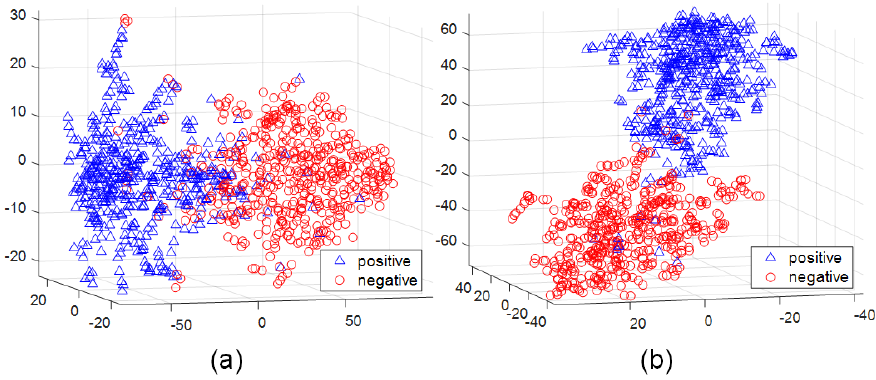
Figure 1. A visualization of the proposed MSSF after mapping it to a lower dimensional space: ( a ) computed features when the neighborhood contains outliers; ( b ) computed features when the neighborhood contains no outliers. Compared with ( a ), red points and blue points in ( b ) distribute more compactly, and the number of points mixed with another class is also reduced. This property is more in agreement with the consequent classification